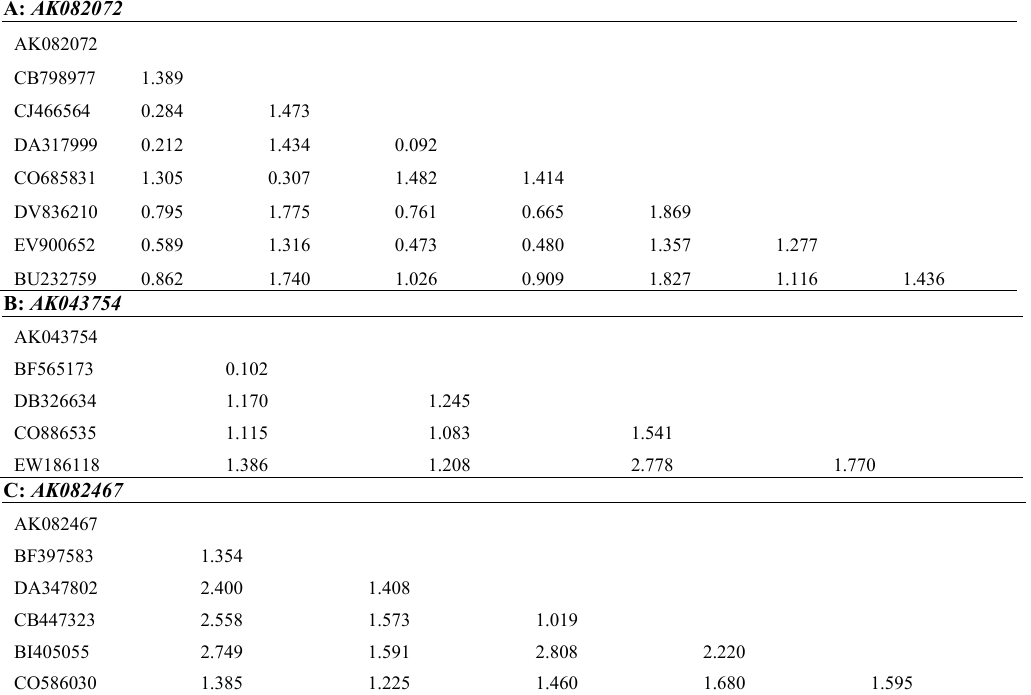
Table 1. Estimates of evolutionary divergence between sequences: All positions containing gaps and missing data were